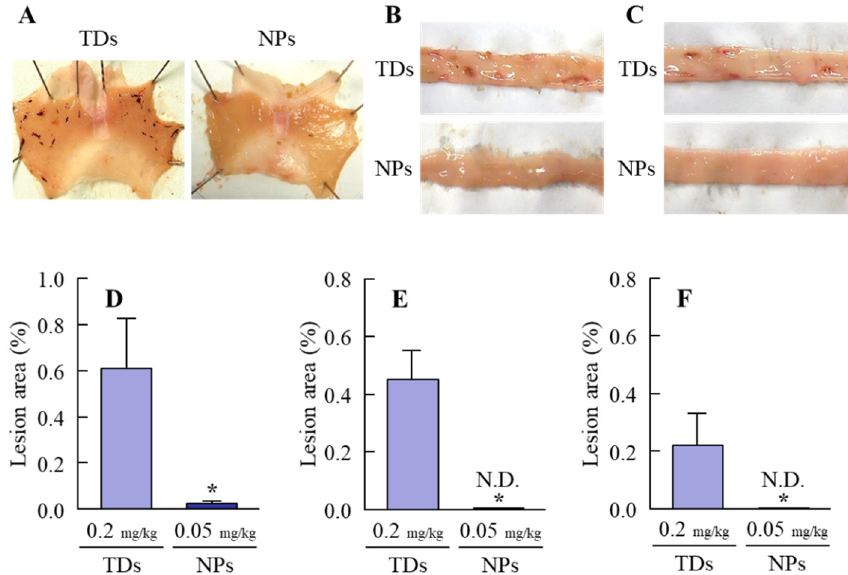
Figure 7. Onset of gastrointestinal lesions by the repetitive administration of 0.2 mg / kg MLX-TDs or 0.05 mg / kg MLX-NPs. (A – C ) Images of the stomach ( A ), jejunum ( B ), and ileum ( C ) of AA rats